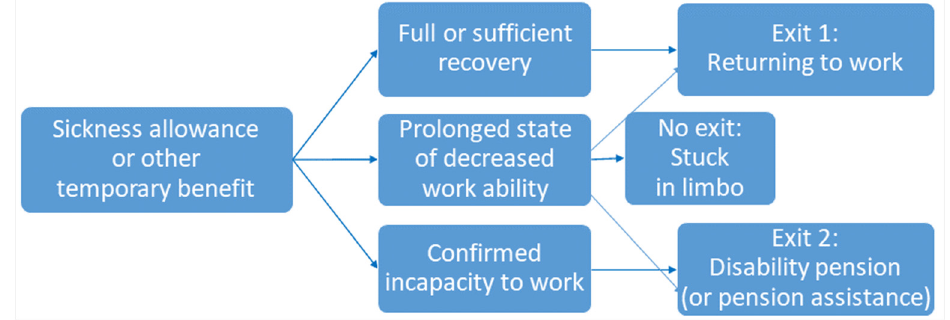
Figure 3. The exit path model. The primary exit from temporary benefits is returning to work. The secondary exit is retiring with a disability pension. (Besides, persons who are over 60 years and unemployed for five years with no or few interruptions, may be eligible for pension assistance, equal in amount to the minimum quarantee pension, in Finland.) If these exits are not available, the individual may be stuck in limbo, circulating between different temporary benefits.